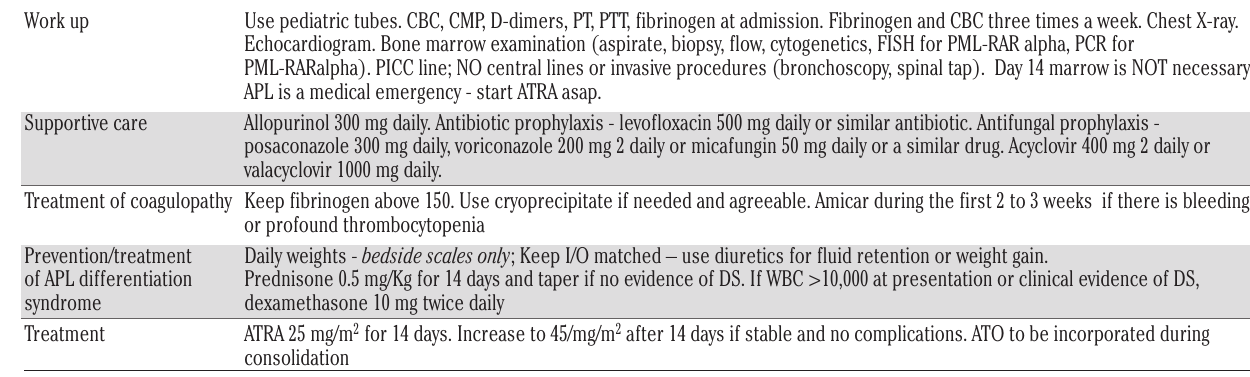
Table 2. Acute promyelocytic leukemia induction suggestions for the Jehovah’s witness patient. Work